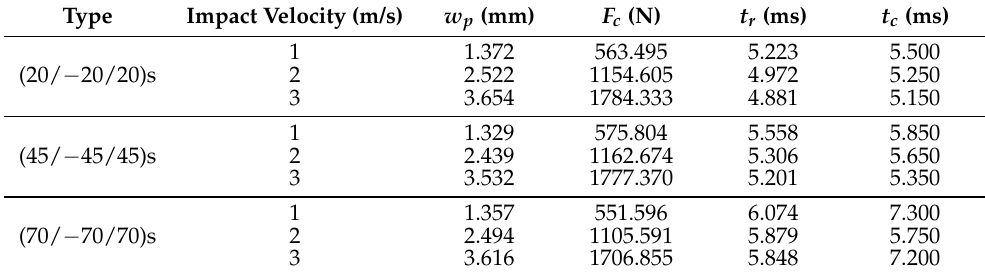
Table 7. Low-velocity impact response of the sandwich structure with various impact velocities. Type